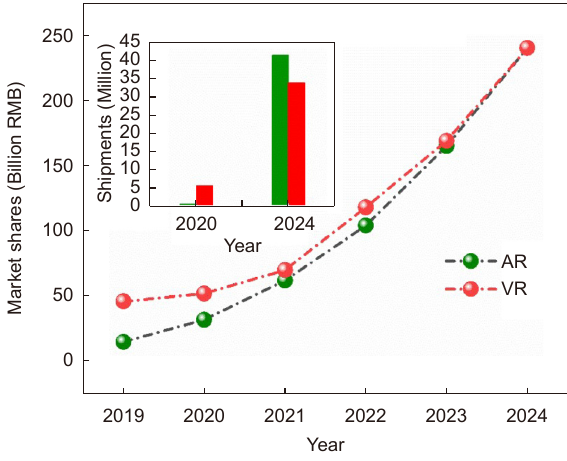
Fig. 1 | The growth of market share of AR/VR 1 .